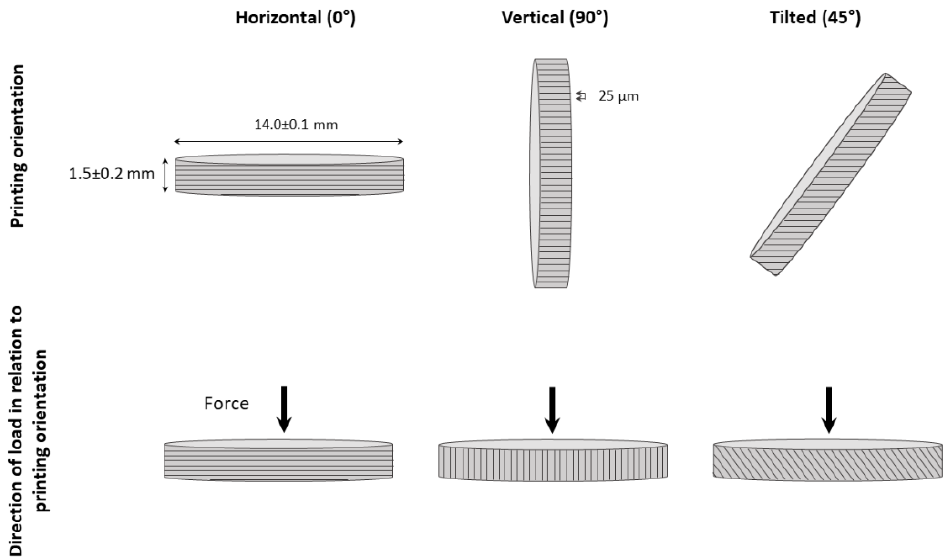
Figure 1. Schematic representation of the specimen printing orientation and relation to the applied load. plied